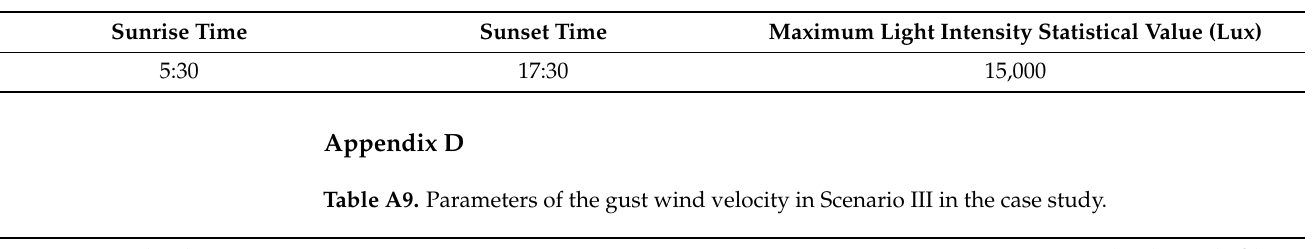
Table A8. Parameters of the interday light components in Scenario II in the case study.